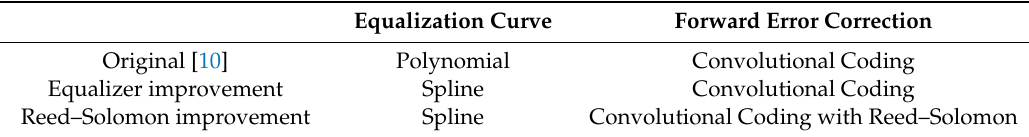
Table 2. Simulation parameters and steps for